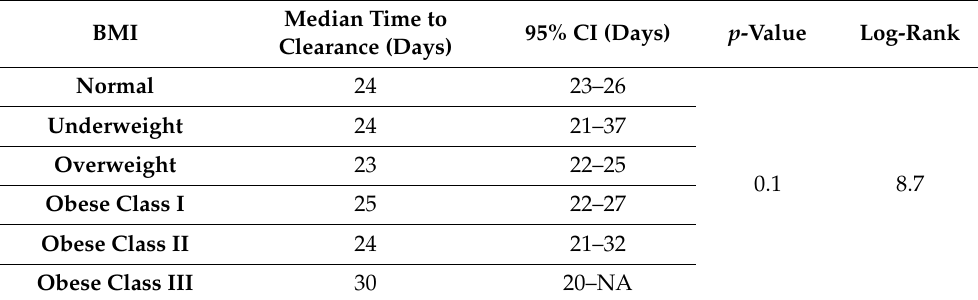
Table 6. Time to viral clearance in relation to BMI category of COVID ‐ 19 patients.